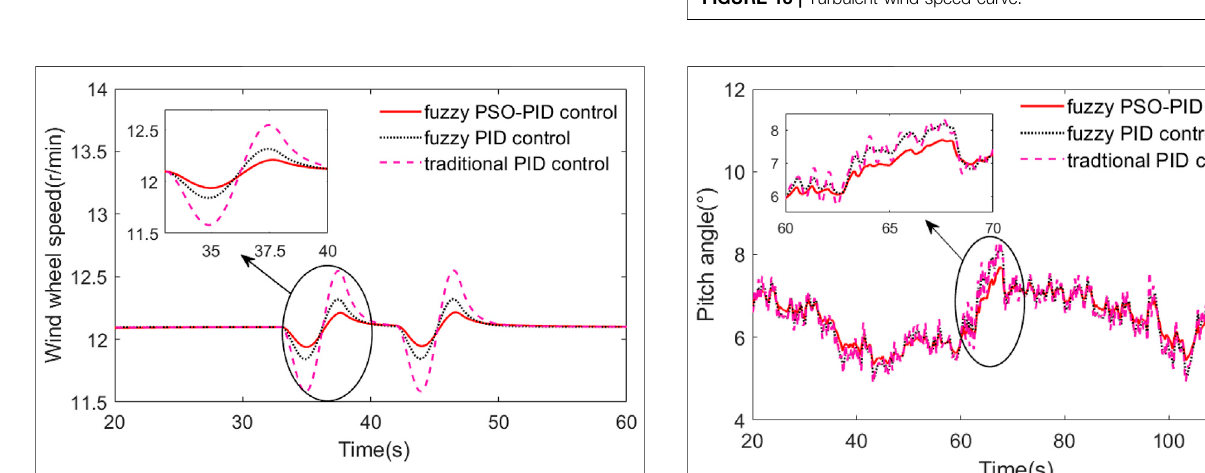
FIGURE 13 | Turbulent wind speed curve.